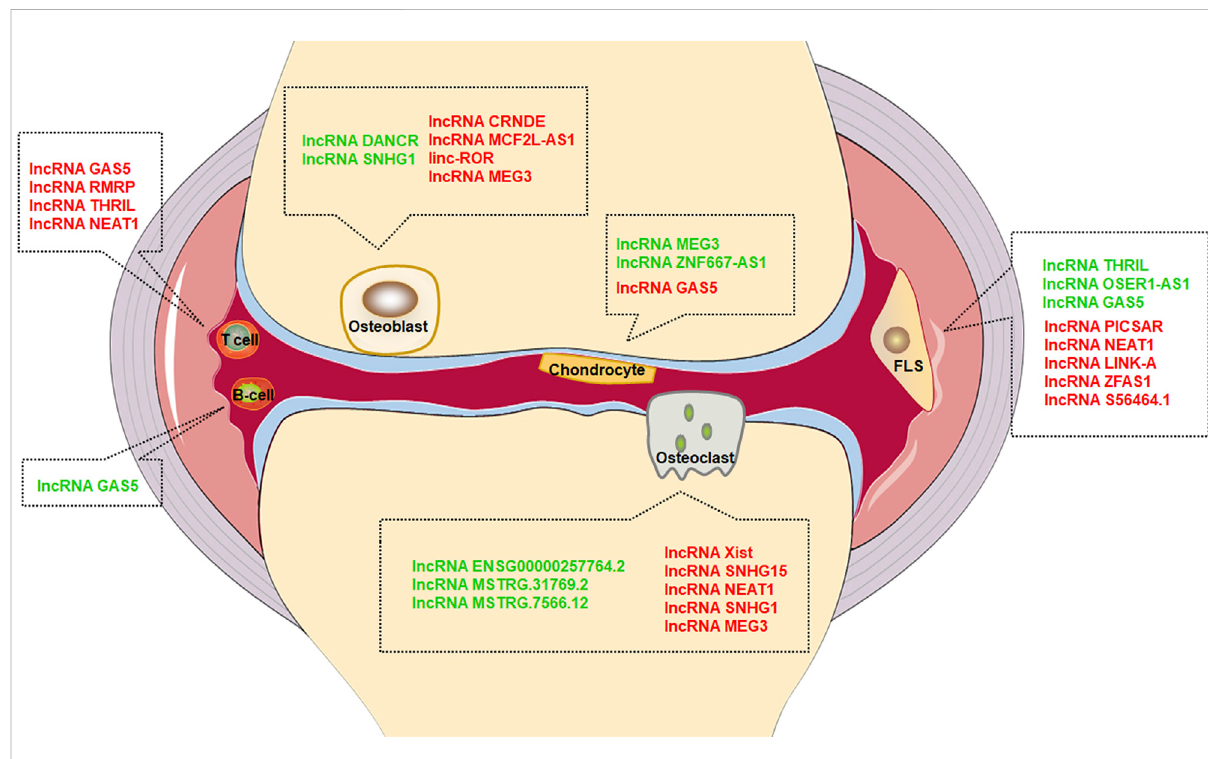
FIGURE 1 Effect of lncRNAs in different cells. Green font represents inhibition, red font represents